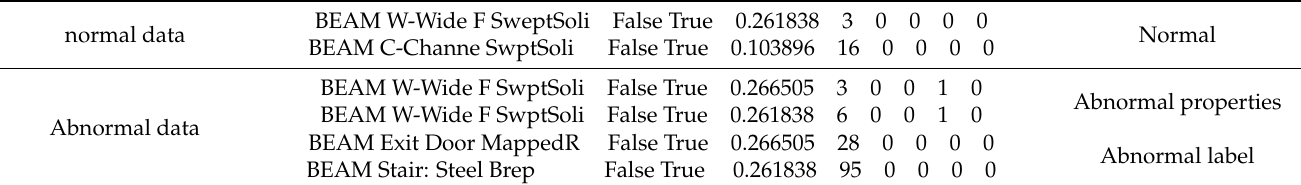
Table 13. Definition of normal and abnormal